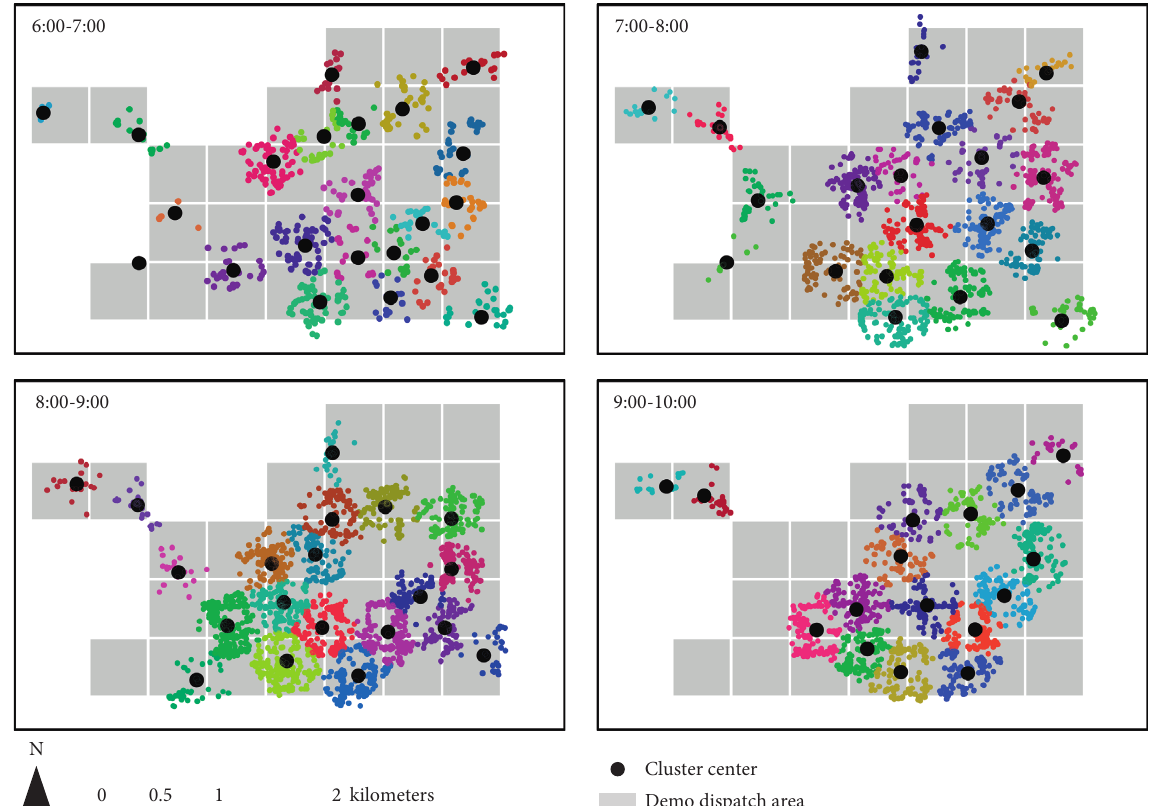
Figure 6: The bicycle gathering area identified by mean-shift clustering in four hours.